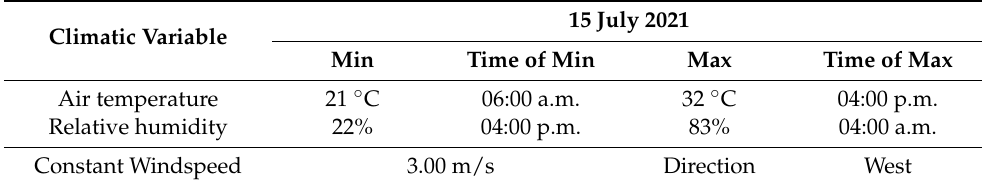
Table 3. Input data in the ENVI-Met simulation model. Climatic Variable